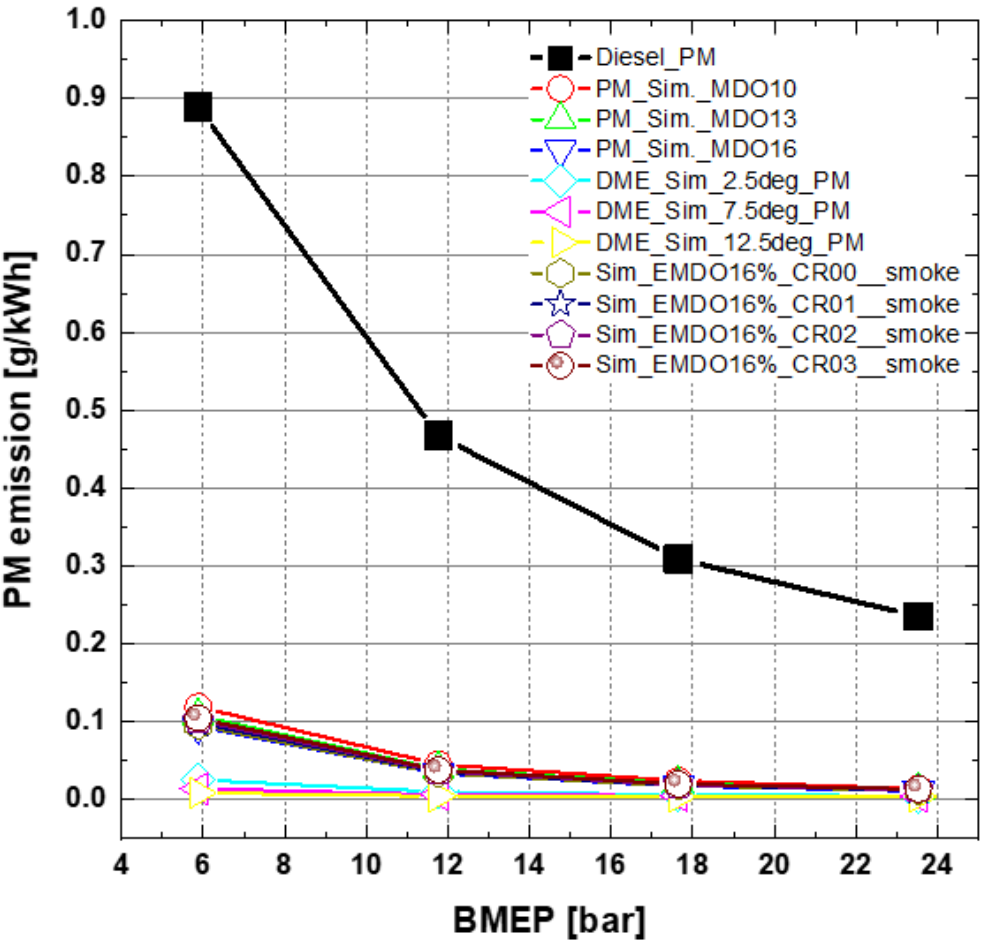
Figure 9. Particulate matter emissions according to MDO, EMDO, and DME fuels due to injection timing, turbocharger compression ratio, and moisture concentration.